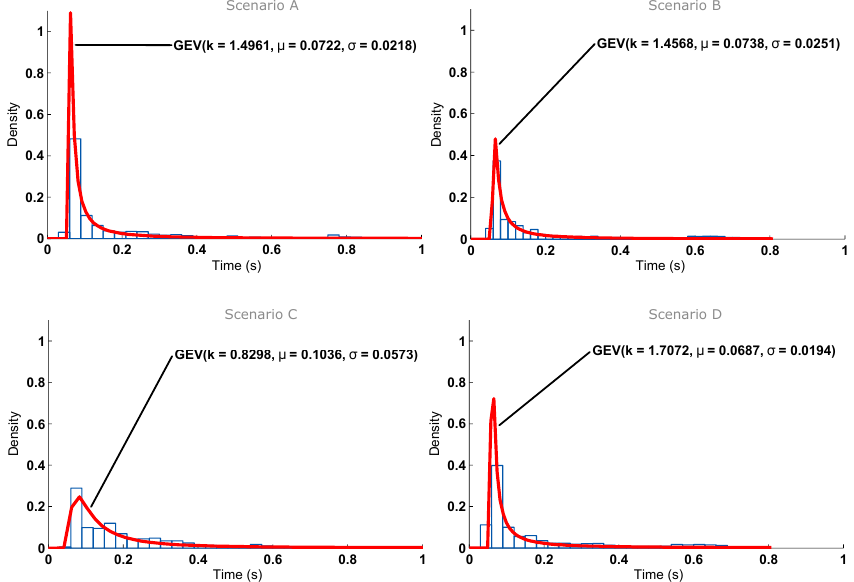
Figure 15. Response time with heavy load on the Wi-Fi segment obtained for the scenarios considered in the test. ( A ) Short distance, line-of-sight; ( B ) Medium distance, line-of-sight; ( C ) Medium distance, non-line-of-sight; ( D ) Medium distance, non-line-of-sight, upstairs.